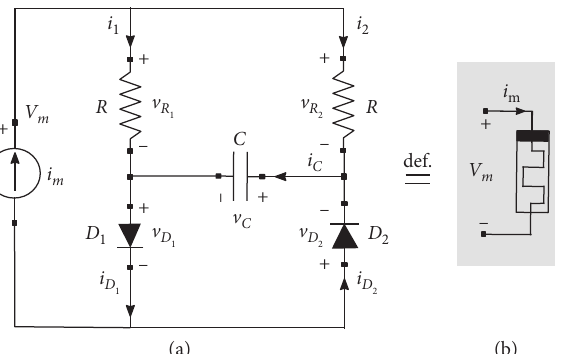
Figure 1: (a) Proposed current-controlled memristor circuit emulator and (b) generalized symbol of the memristor